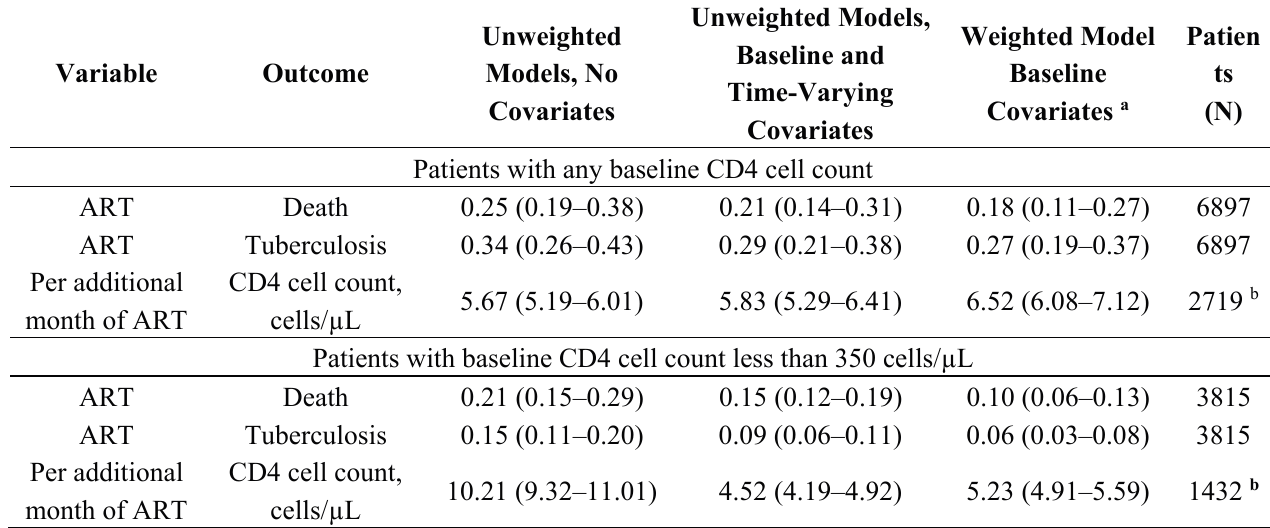
location and months of follow-up. Table 3. Estimated Effects of ART from Unweighted and Weighted Cox